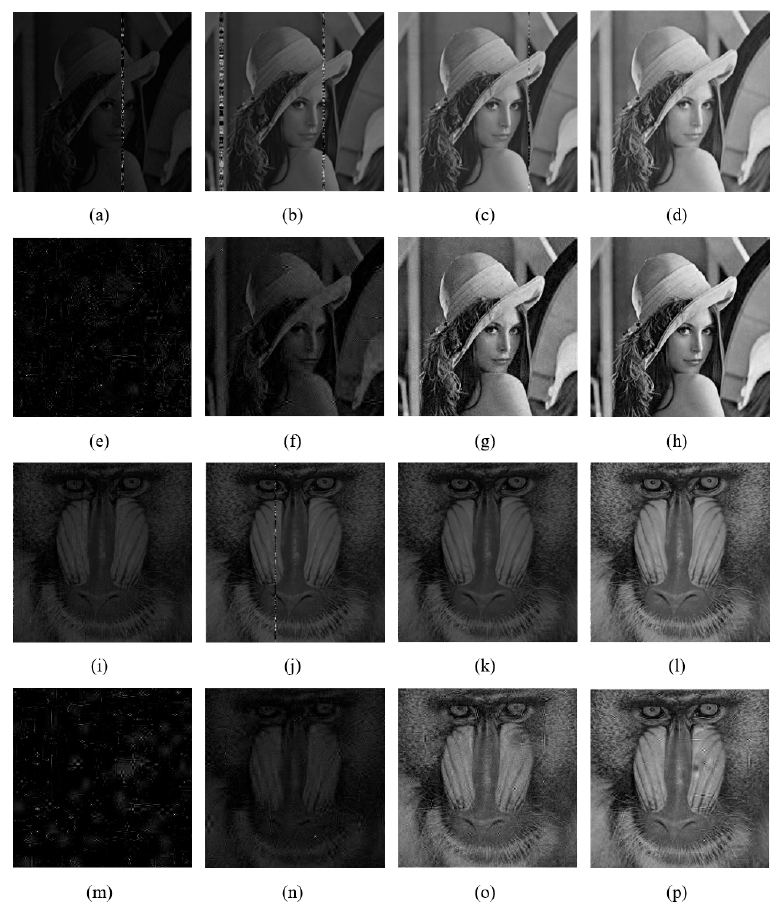
Figure 12. Comparison of DWT and K-SVD. ( a – d , i – l ) are the decrypted images using the K-SVD algorithm, and ( e – h , m – p ) are those using the DWT algorithm. The compression ratios from left to right are 8, 4, 2 and 1.33, respectively.